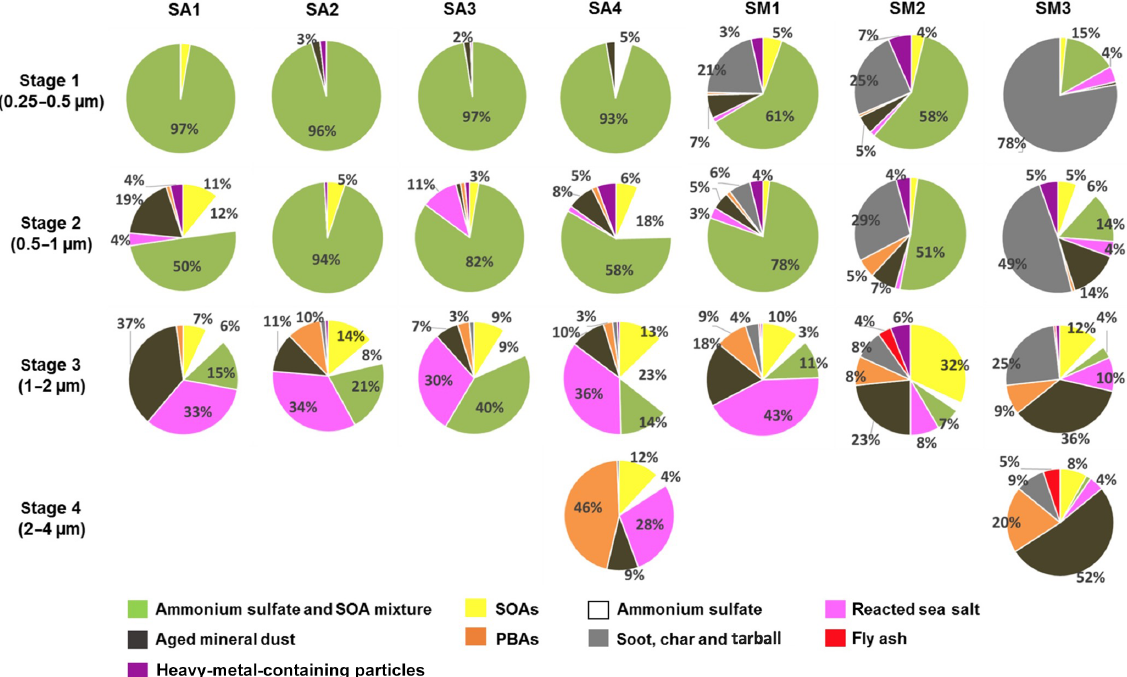
Figure 13. Relative number abundance of nine different particle types for the SA1–SA4 and SM1–SM3 samples collected at the ATTO and Manaus sites,